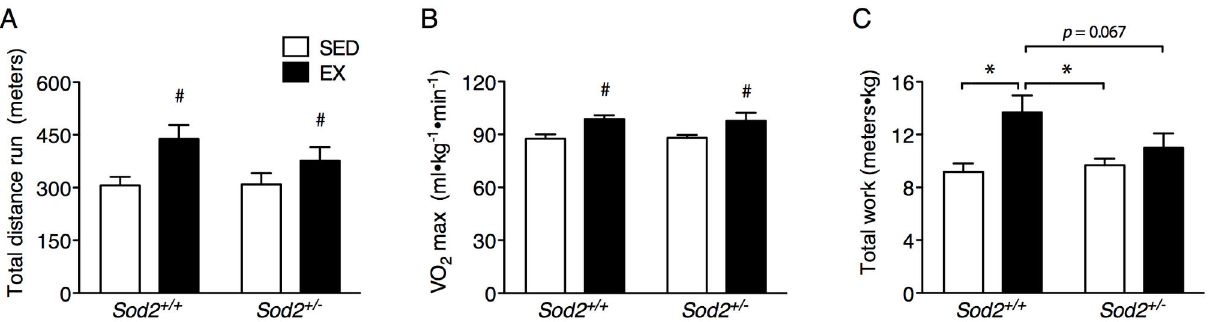
Figure 1. Elevated mitochondrial oxidative stress impairs the improvement in work capacity resulting from exercise training. Mice were tested for exercise capacity on a treadmill at a 10-degree angle after 4 months of exercise training or remaining sedentary as stated in the Materials and Methods. (A) Total distance run, (B) VO exercise test to exhaustion. (For resting data regarding body weight, VO Data are mean±SE. n = 7-8. *Indicates a significant difference ( p < 0.05) from the indicated group as determined by ANOVA. # Indicates a main effect of exercise training. doi: